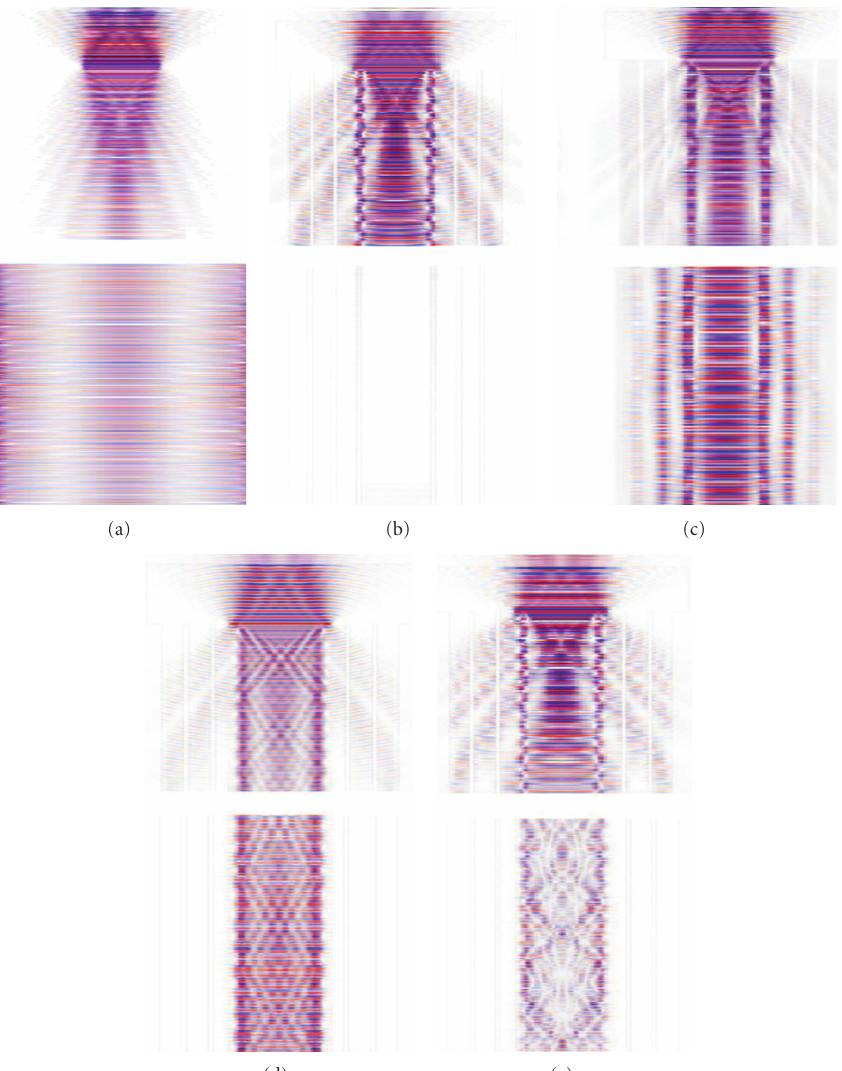
Figure 11: Light propagation when focusing a Gaussian beam at (a) the surface of a bulk liquid medium (water), (b) the entrance of a HCPCF with open air channels, (c) the entrance of a HCPCF with all channels filled with liquid, (d) the entrance of a LCPCF with only the core channels filled with liquid, and (e) the entrance of a LCPCF with a 200 µ m air gap between the entrance and the liquid surface. In each set of images, the top one corresponds to the field distribution near the entrance of either bulk medium or HCPCF, while the bottom one corresponds to the field distribution after a propagation distance of 400 µ m from the